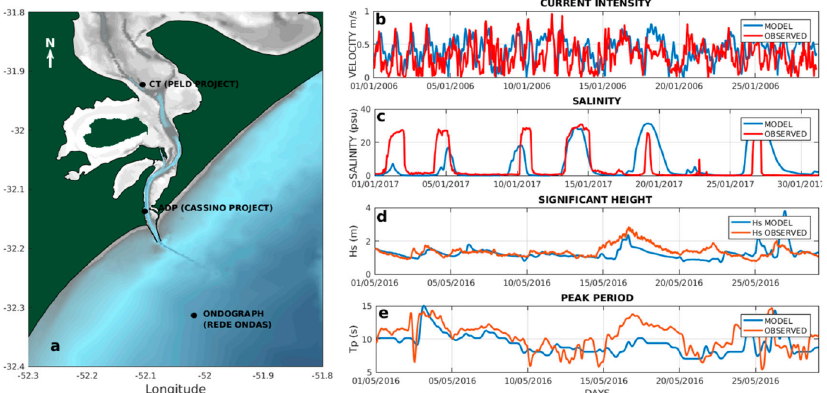
Figure 3. ( a ) Location of stations from where measured data were obtained during 2006, 2016 (Rede Ondas Project) and 2017 (PELD Project) for ( b ) the calibration of the hydrodynamic model, ( c ) the validation of the hydrodynamic model, and ( d , e ) the validation of the wave model. The solid blue line indicates model results, while the red solid line indicates measured